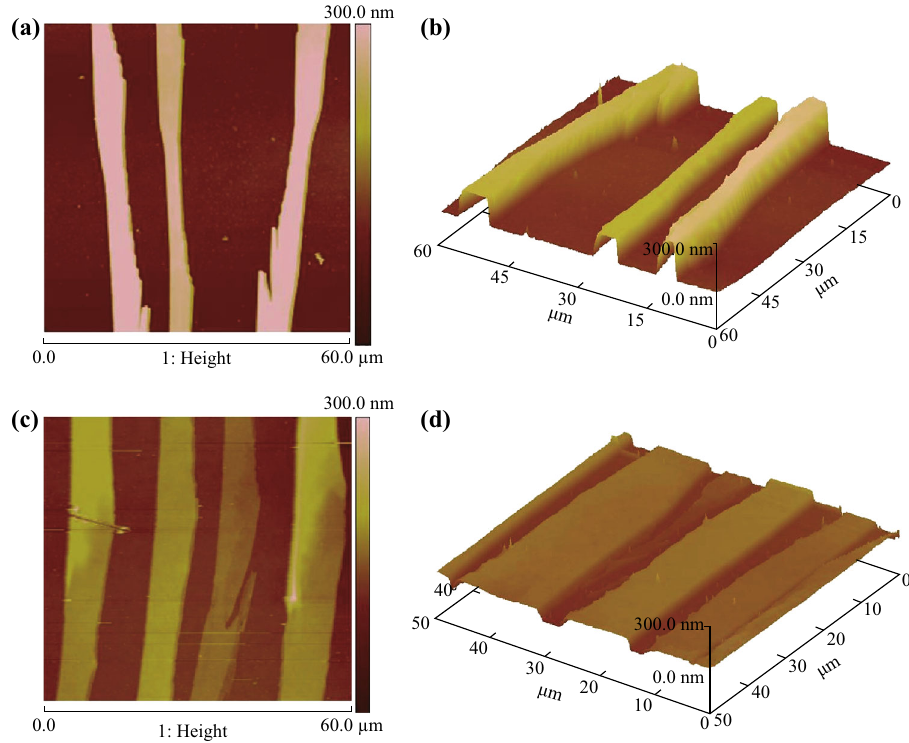
Fig. 5 AFM images of BPEA nanoribbon arrays ( a , b ) and TIPS-PEN nanoribbon arrays ( c , d ) formed at a coating speed of 80 l m s -